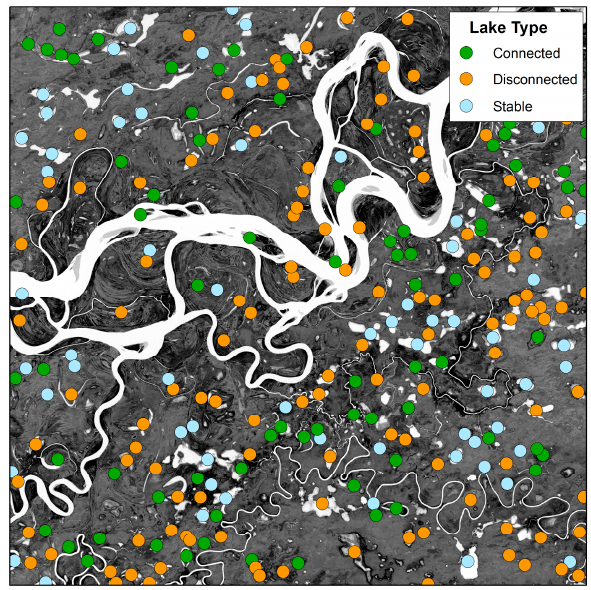
Figure 9. Temporal correlation between Planet time series of lake surface area and Yukon River discharge reveal connected (green), disconnected (orange) and stable (light blue) lakes. Green dots are connected lakes (surface area standard deviation >10%, correlated to Yukon River discharge at p < 0.1), orange are disconnected (surface area std >10%, not correlated to Yukon River discharge) and light blue are stable (surface area std <10%).